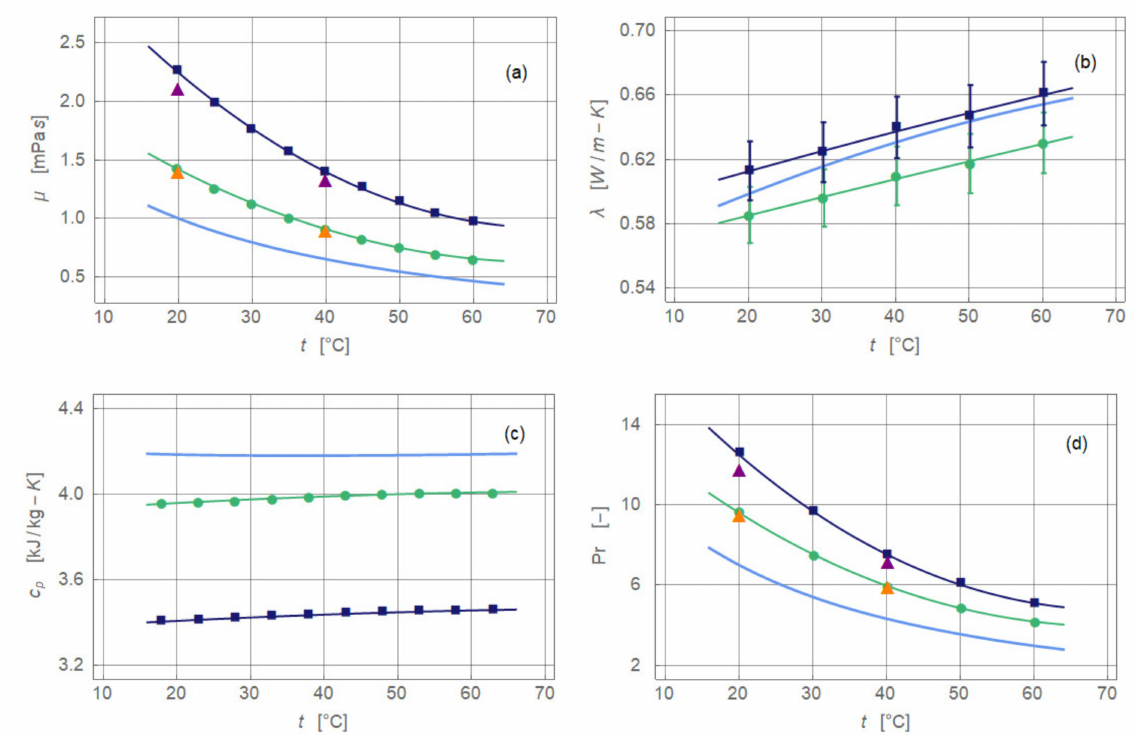
Figure 2. Thermophysical properties of water, base fluid and ferronanofluid. The plots show ( a ) dynamic viscosity, ( b ) thermal conductivity, ( c ) specific heat capacity, and ( d ) Prandtl number. The colours stand for DI-water (light blue, [8]), base fluid (green), and ferronanofluid (dark blue). Symbols indicate experimental data and full curves polynomial fits. Orange triangles indicate base fluid and purple triangles ferronanofluid viscosity measurements with Ubbelohde capillary. Thermal conductivity is determined between 20 and 60 ◦ C with an increment of 10